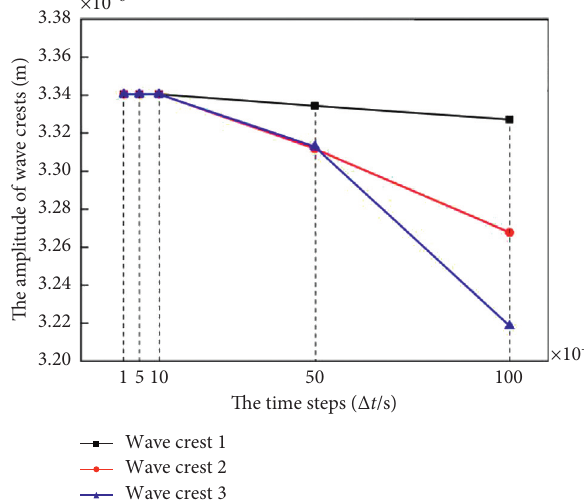
Figure 6: Time-domain diagram of x steps.